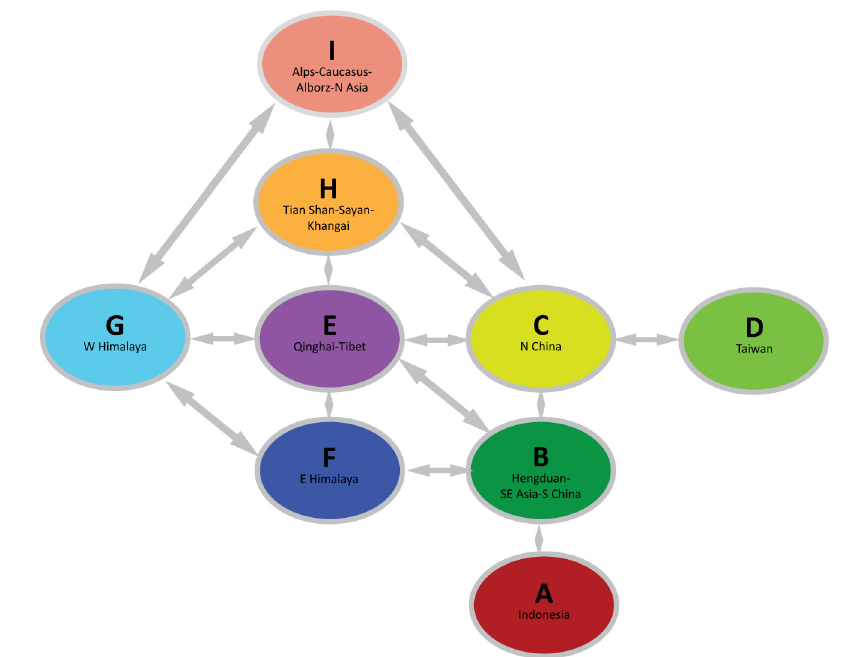
Fig. 23. Diagram representing a corridor-dispersal model, encompassing a set of the short-distance dispersal events permitted (in either direction) between the areas defined in Table 5, based on their geographical proximity and the likely disposition of corridors with suitable habitat and favourable climates in the